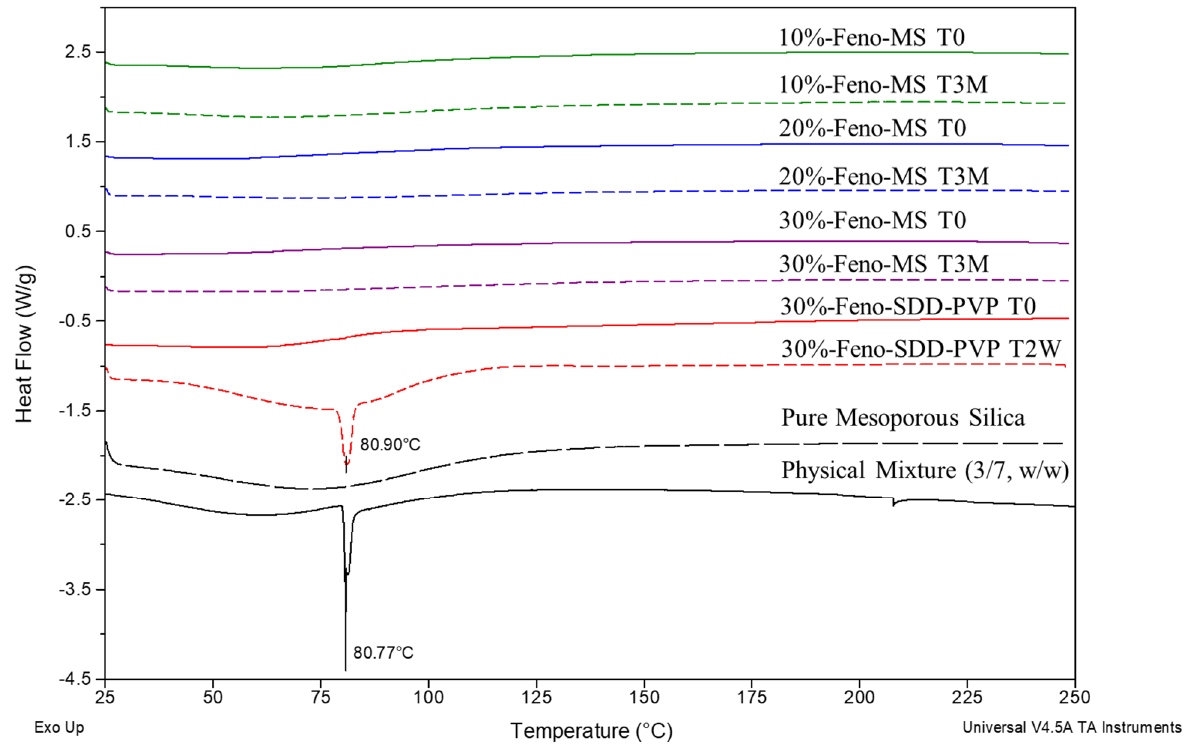
Figure 4. The DSC overlay of Feno-MS samples (10–30% drug load at T0 and T3M under accelerated conditions of 40 °C/75% RH in open dish), Feno-SDD-PVP samples (30% drug load at T0 and T2W under the same accelerated conditions), pure mesoporous silica (Parteck ® SLC), and the physical mixture of crystalline fenofibrate and mesoporous silica at a weight ratio of 3:7 ( w / w ).